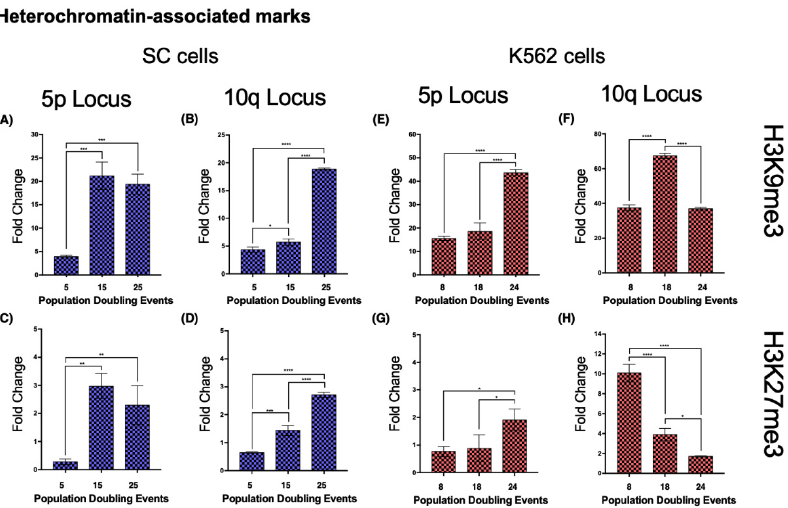
Figure 8. Heterochromatin-associated histone marks accumulated on both analyzed loci in the SC cell line. Chromatin immunoprecipitation was carried out to determine the abundance of the heterochromatin-associated histone marks, H3K9me3 and H3K27me3. Note the different scales on the axes of the graphs. ( A – D ) As the culture aged, both marks accumulated in loci 5p and 10q of the SC cells. ( E , G ) In K562 cells, locus 5p also accumulated both heterochromatin-associated marks. ( F ) The levels of H3K9me3 only increased temporarily at locus 10q after 18 PDs in K562 cells. ( H ) The levels of H3K27me3 decreased at locus 10q as K562 cells aged. Notably, in both cell lines, the levels of H3K9me3 were always considerably higher than those of H3K27me3. Data were analyzed using ANOVA and Tukey’s multiple comparisons test. Adjusted p value < 0.0001 (****), <0.001 (***), <0.01 (**), <0.05